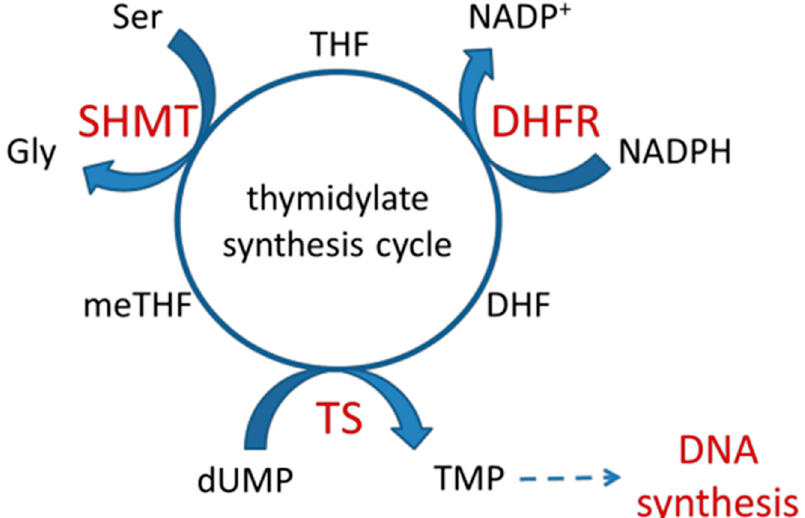
Figure 1. Thymidylate synthesis cycle. TS—thymidylate synthase; DHFR—dihydrofolate reductase; SHMT—serine hydroxymethyltransferase; dUMP—2 ′ -deoxyuridine-5 ′ -monophosphate; TMP, TDP, TTP—2 ′ -deoxythymidine-5 ′ -mono-, di-, and triphosphate, respectively; DHF—dihydrofolate; THF—tetrahydrofolate; meTHF—N5,10-methylenetetrahydrofolate.